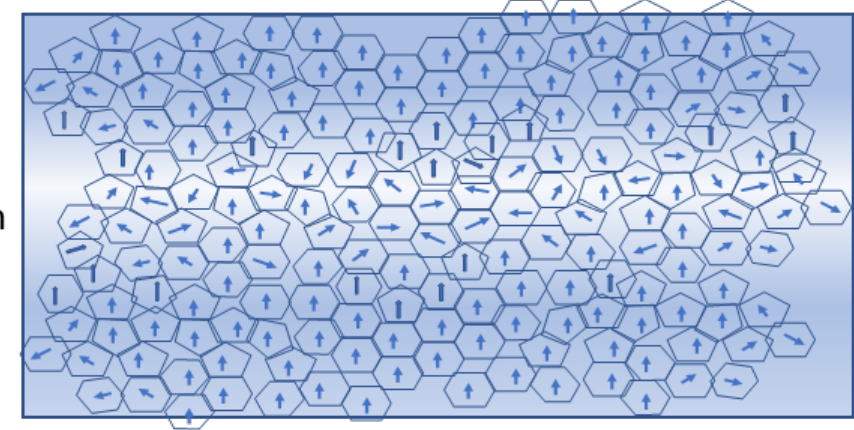
Figure 9. This cartoon represents the regions of ordered crystallites where many of them are oriented in the same direction because if the lattice stretching shown in Figure 8. This would be analogous to a sound wave passing through a dense medium. The “computation” is thus the result of constructive and destructive interference between the data stream and the control stream. In the diagram we used mixed pentagons and hexagons to represent the ~1micron crystallites, and the gaps between them would represent interstitial regions in the compressed